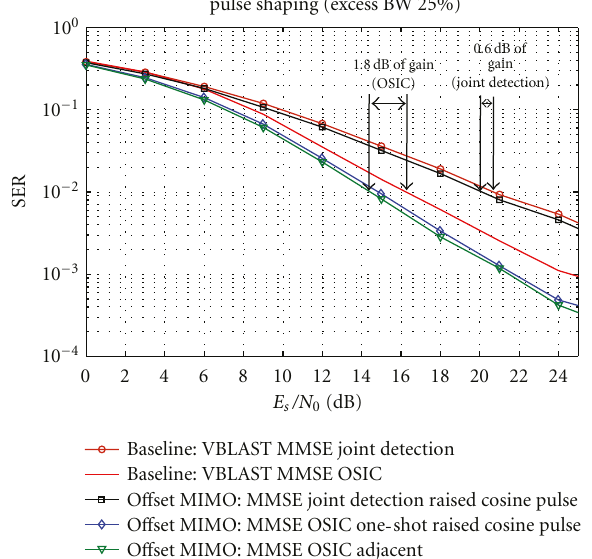
Figure 11: O ff set MIMO with SRRC pulse shaping versuss OSIC VBLAST, ( M T , M R ) = (2,2), modulation = QPSK.